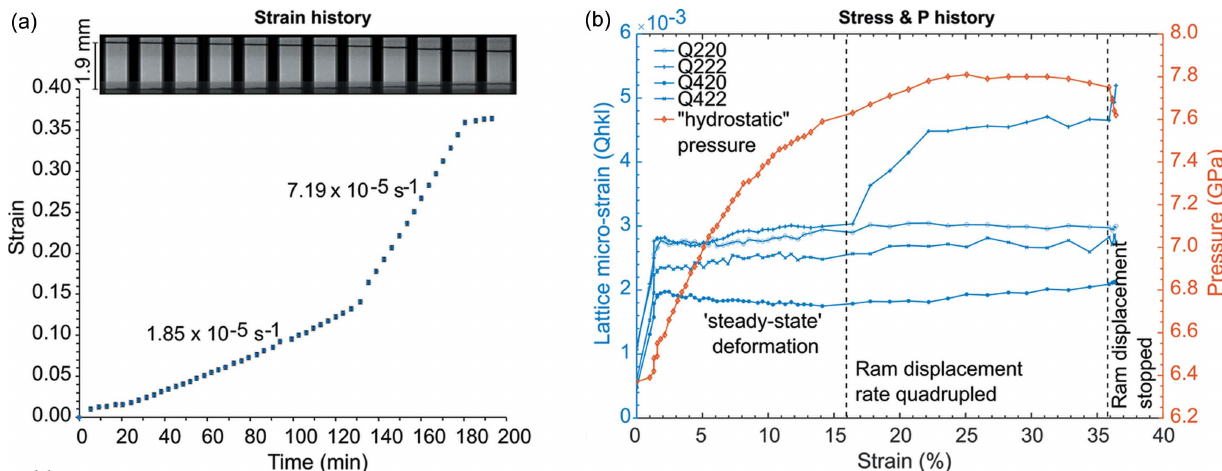
Figure 11 Deformation of NaCl at high pressure and room temperature. ( a ) Strain history was obtained by X-ray radiography. The black lines in the snapshot images are Pt metal foil disks between the sample and the alumina pistons and indicate the shortening ( i.e. strain) in the sample at constant displacement rate of the hydraulic rams (1 and 2). The strain increments (blue points) were calculated as a function of time from each radiography image. The error in the strain estimation of each step is approximately (cid:6) 0.0013 (symbol size). The data are fitted by linear functions to obtain the strain rate at each deformation step. ( b ) Diffraction data of NaCl (data points), obtained after each capture of a radiographic image are evaluated for Q ( hkl ), a representation of the lattice micro-strain ( i.e. stress) for selected hkl , and plotted against strain. The pressure history during deformation is calculated from d P ( hkl ) using the equation of state in the work by Brown (1999). While random errors in Q( hkl ) and d P ( hkl ) are expected to be low in the data, large systematic errors are expected (using only two Ge-SSDs) and are not evaluated